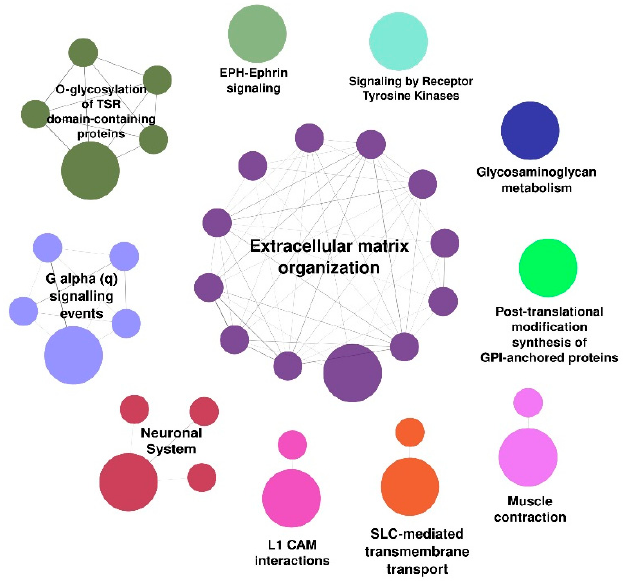
Figure 3. Summary of the Reactome categories and functional pathways enriched in bladder body urothelium (shown in Table S3). Big dots—category; small dots—pathways.